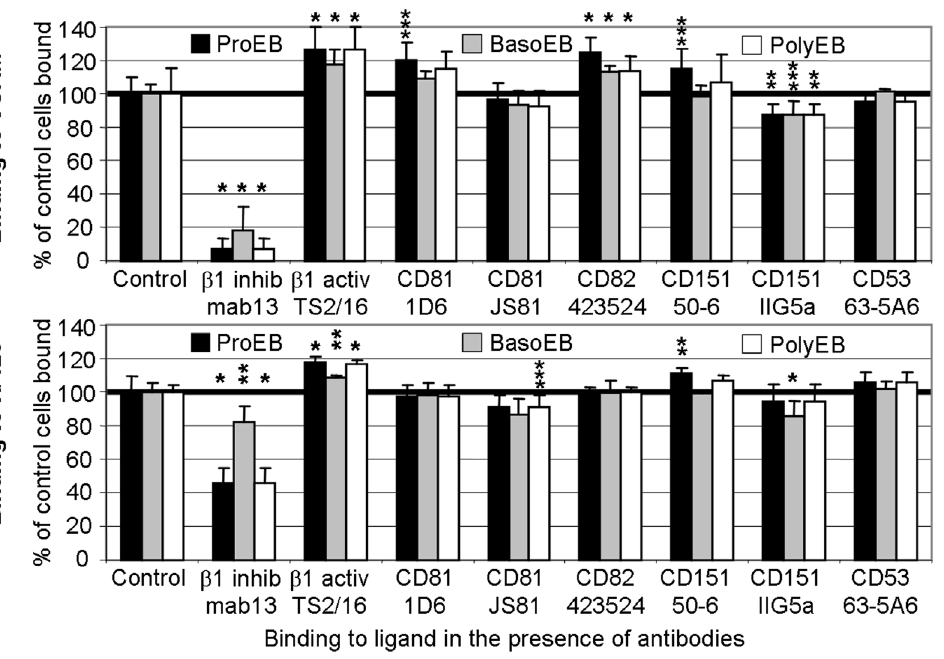
Figure 6. Effect of anti-tetraspanin antibodies on erythroblast attachment to Vascular Cell Adhesion Molecule-1 and fibronectin fragment H/120. Attachment of erythroblasts to ligand in the presence of 1 mM Ca 2 + plus 1 mM Mg 2 + and 10 m g/ml of isotype control, inhibitory or activating anti- b 1 and anti-tetraspanin antibodies. Each data point is the mean of 6 replicates, each expressed as the percentage of the average of the relevant isotype control cells bound (the normalised values); standard deviations are shown, calculated from the normalised values. The results depicted are from the same culture at 3 time points (ProEB, day 5; BasoEB day 8; PolyEB, day 12) and are representative results of the series of data collected. *, P , 0.001; **, P , 0.050; ***, P=0.050–0.055 compared with the relevant isotype control values as determined by one way analysis of variation. Box-Whisker plots of the complete series of experiments performed with CD81, CD82 and CD151 clones with both ligands, with statistically significant results highlighted, are depicted in Figures S5 and S6. Altogether 6 cultures were assayed (days 5 and 8 were performed on 5 occasions, day 12 on 4 occasions). The pre-coating concentrations of VCAM-1 and H/120 allowed slightly less than maximal cell attachment. VCAM-1 was pre- coated at 0.2 m g/ml, 0.125 m g/ml and 0.25 m g/ml while H/120 was pre-coated at 2 m g/ml, 1.25 m g/ml and 1 m g/ml for proerythroblasts (ProEB, black bars, day 5), basophilic erythroblasts (BasoEB, grey bars, day 8) and polychromatic erythroblasts (PolyEB, white bars, day 12) respectively. Readings in excess of 100% input cells bound were sometimes evident in haemoglobinised cells (days 8 and 12). High levels of haemoglobin within the cells quenches the fluorescence of the initial 100% input cells bound reading, and was evident only with day 12 cells in this assay (all the H/120 results and only the VCAM-1 with TS2/16 result); this artefact does not occur with non-haemoglobinised day 5 cells. Day 5 culture comprised 5% pre- proerythroblasts, 91% proerythroblasts and 4% basophilic erythroblasts (28% GPA + ); day 8 culture comprised 11% proerythroblasts, 60% basophilic erythroblasts and 28% polychromatic erythroblasts (88% GPA + ); day 12 culture comprised 15% basophilic erythroblasts, 48% polychromatic erythroblasts, 15% orthochromatic erythroblasts and 21% reticulocytes (99% GPA + ). (data not shown), despite evidence for increased integrin affinity induced by Mn 2 + at the basophilic stage (BasoEB, figure 5).